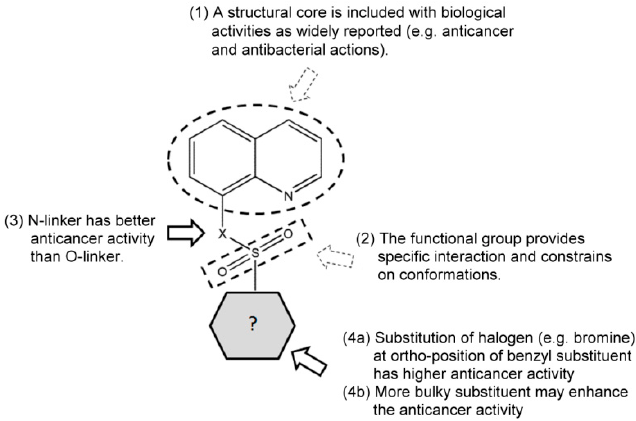
Figure 4. Structure-and-activity relationship of the designed and prepared sulfonyl-containing